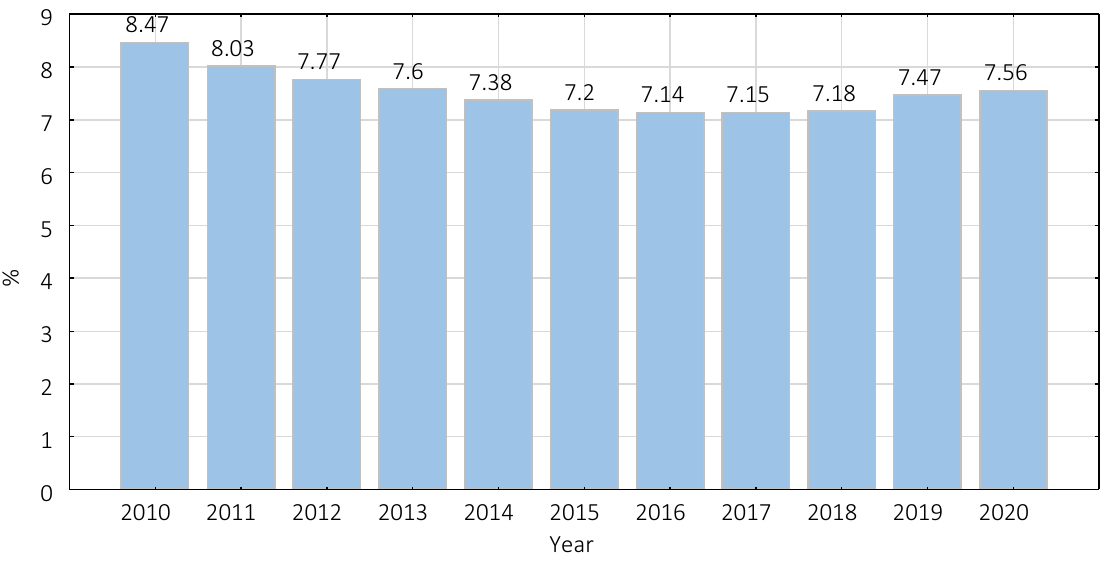
Figure 2. The share of the construction industry in total employment